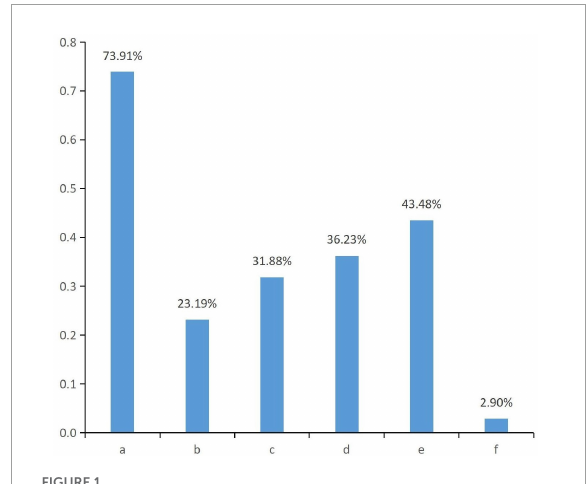
FIGURE1 Access to sources of emotional support. a. Immediate family members; b. Other relatives; c. Friends, colleagues; d. Organ donor coordinators; e. Official organizations, such as government, Red Cross, etc.; f. Unofficial organizations, such as religious and social